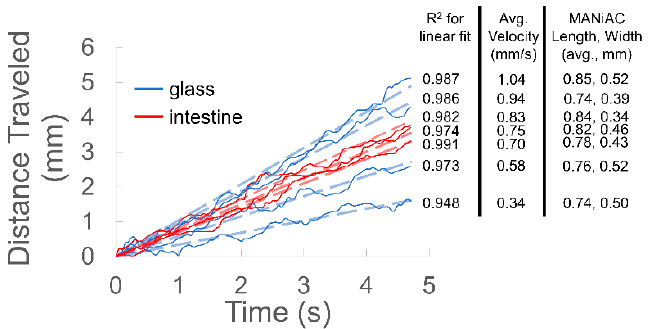
Figure 4. MANiAC velocity on glass and intestine surfaces. Linear fits of the capsule motion, average capsule velocity, and capsule size are also included.